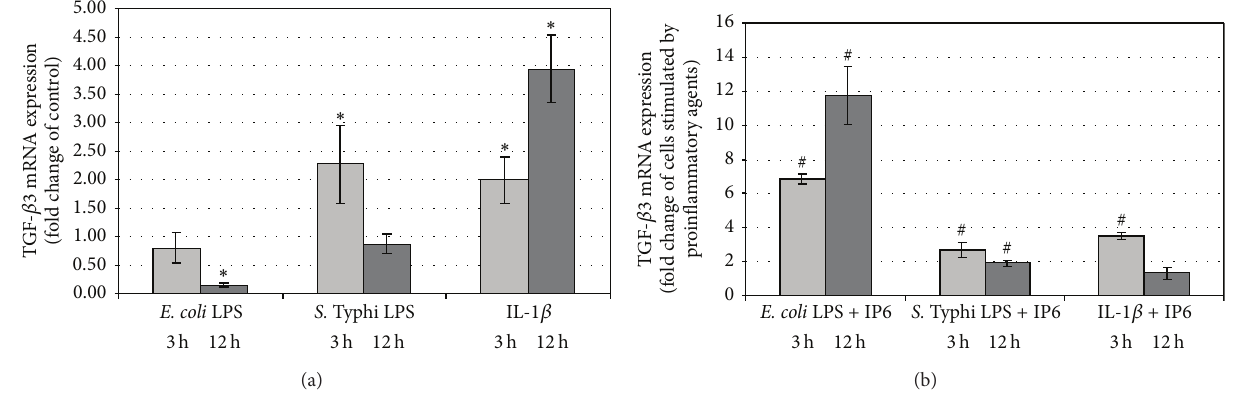
Figure 3: Expression of TGF- 𝛽 3 gene in Caco-2 cells as determined by real-time RT-PCR. Changes in TGF- 𝛽 3 mRNA expression in Caco- 2 cells after treatment with (a) proinflammatory agents and (b) proinflammatory agents and 2.5mM IP6 for 3 h and 12h. The results are presented as mean ± SD of three separate experiments; ∗ 𝑃 < 0.05 versus control Caco-2 cells; # 𝑃 < 0.05 versus proinflammatory agents- stimulated